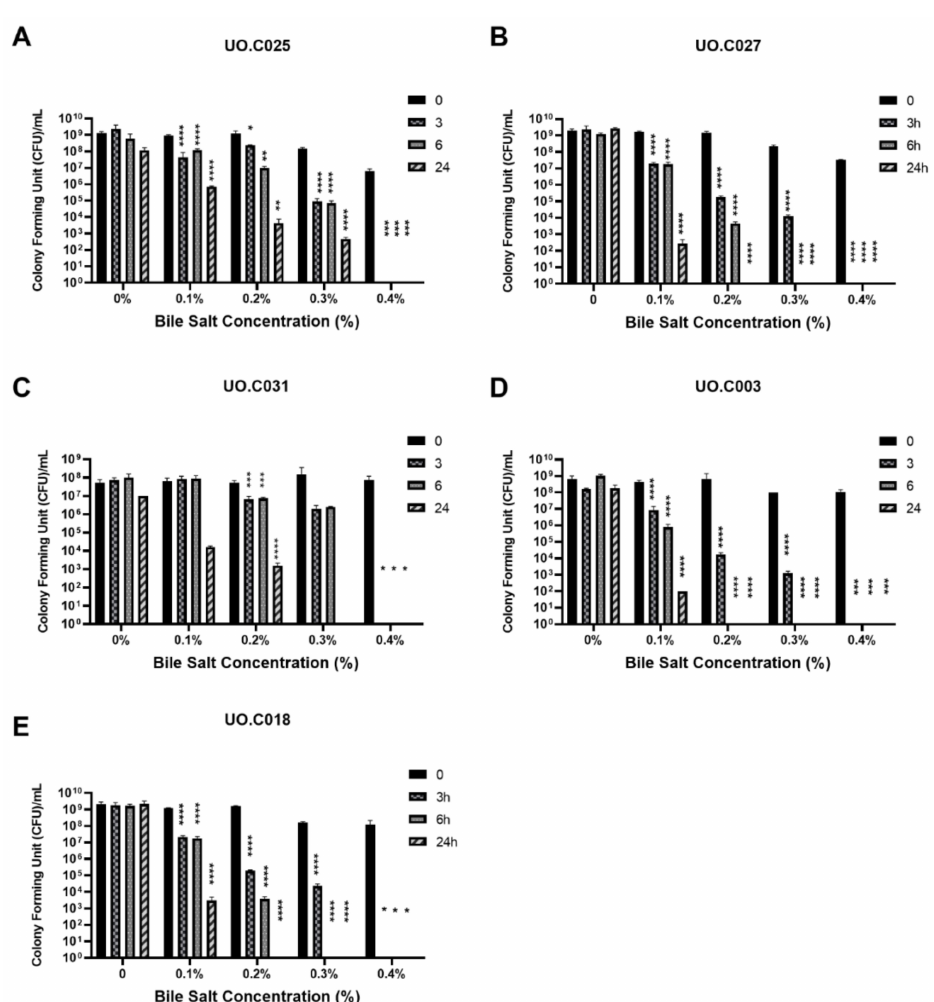
Figure 4. Isolated strains tested for bile salt tolerance in simulated intestinal juice at times 0, 3, 6, and 24 h. One-way ANOVA followed by Dunnett’s multiple comparison test were used for statistical comparison of the difference between each time point and the zero time. * p < 0.05, ** p < 0.01, *** p < 0.001, **** p < 0.0001 as compared to the zero time of each